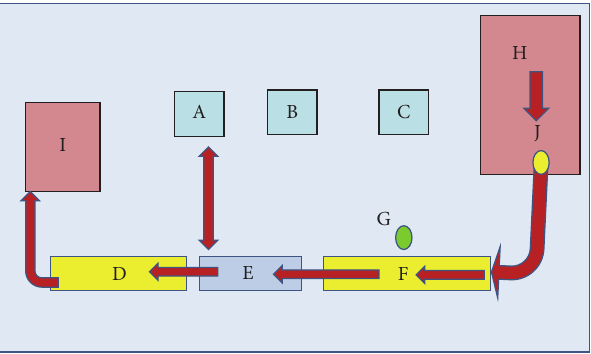
Figure1:2Drepresentationofsystem,whereAisinductionfurnace, B is induction heating generator, C is transformer, D is conveyor 1, E is conveyor 2, F is conveyor 3, G is camera, H is mold preparation area, I is cooling area, and J is mold and